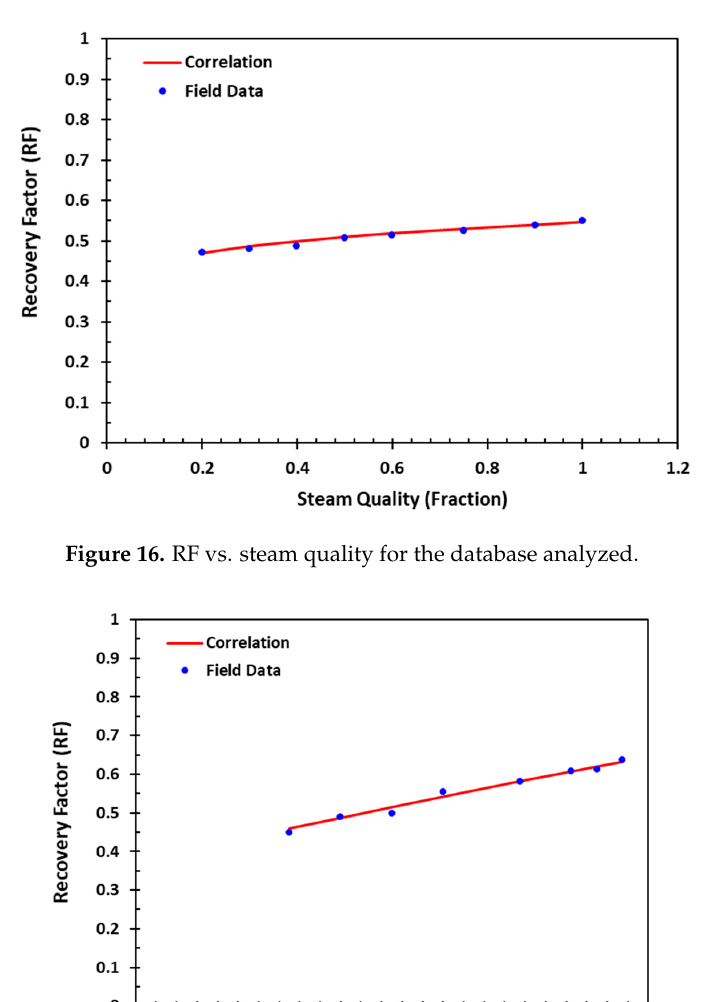
Figure 14. RF vs. gross to net thickness ratio for the database analyzed. Figure 15. RF vs. gross to net thickness ratio for the database analyzed. Energies 2018 , 11 , x FOR PEER REVIEW